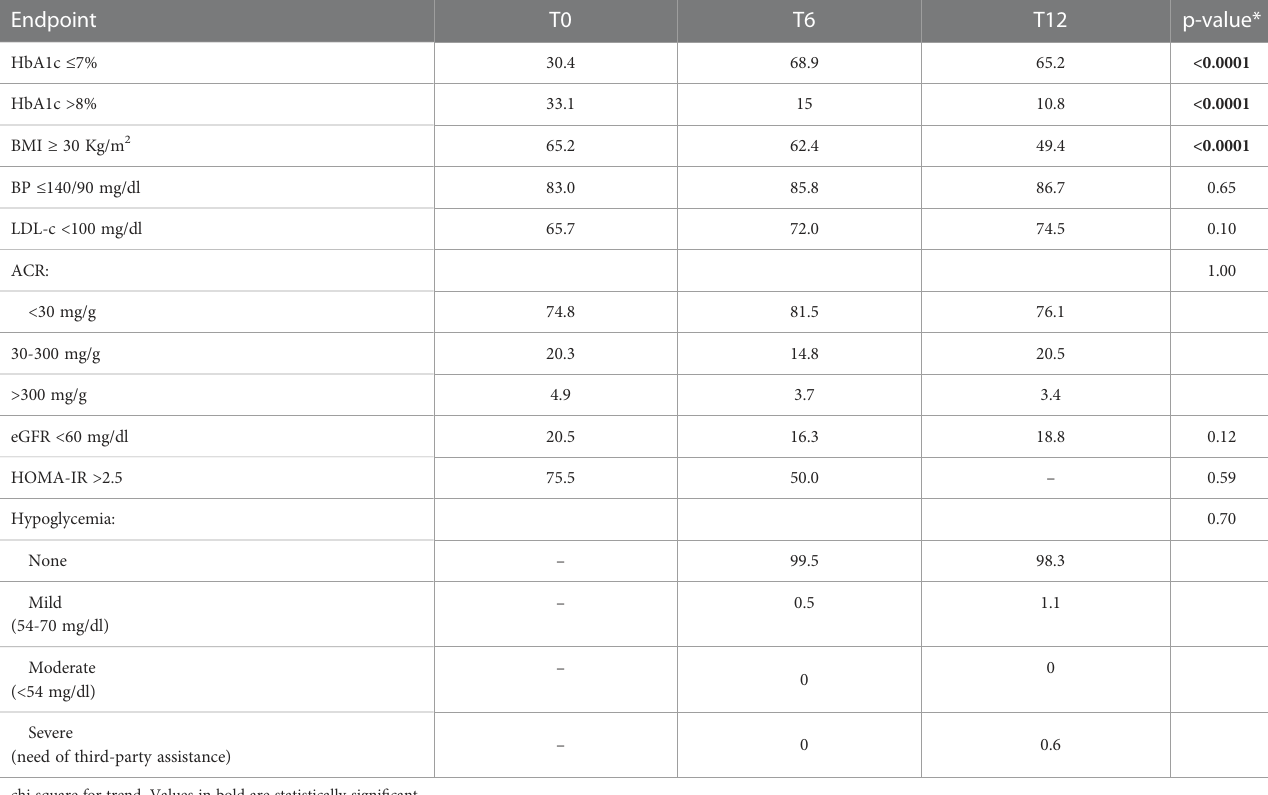
TABLE 3 Changes in categorical